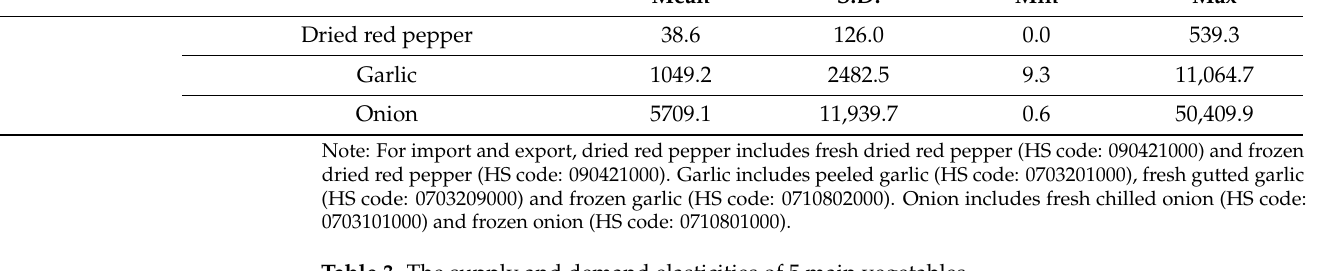
Table 3. The supply and demand elasticities of 5 main